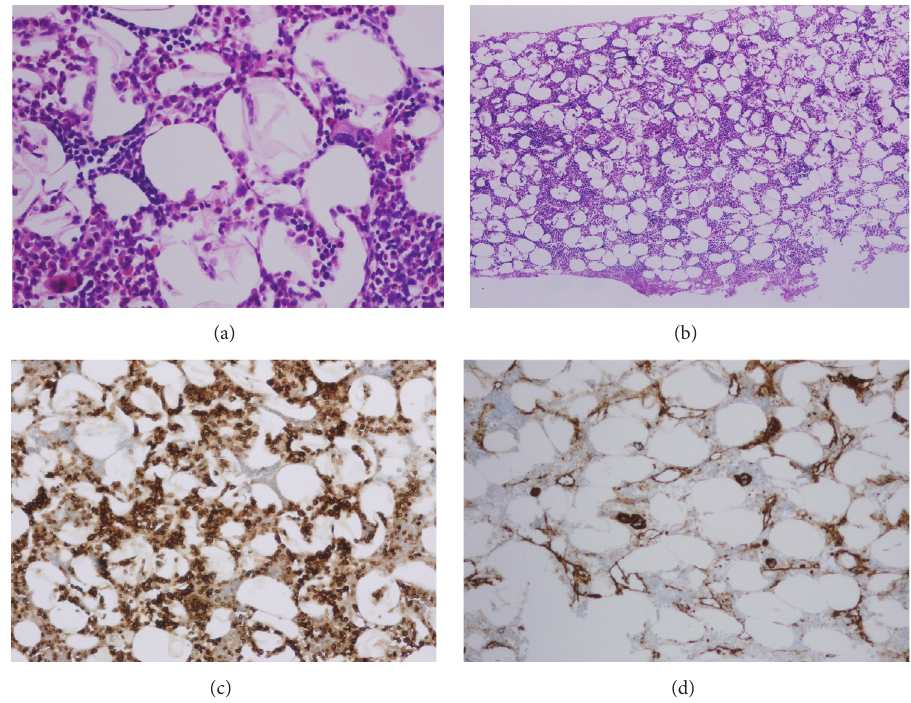
Figure 4: Histopathology of the tumor shows mature adipose tissue mixed with hematopoietic tissue, which included erythrocytes, myelocytes, and megakaryocytes. Immunohistochemical staining confirmed the presence of hematopoietic elements consisting of myeloperoxidase-positive myeloid elements and factor VIII-positive megakaryocytes (HE stain (a) × 400, (b) × 40, (c) myeloperoxidase- positive myeloid elements, and (d) factor VIII-positive